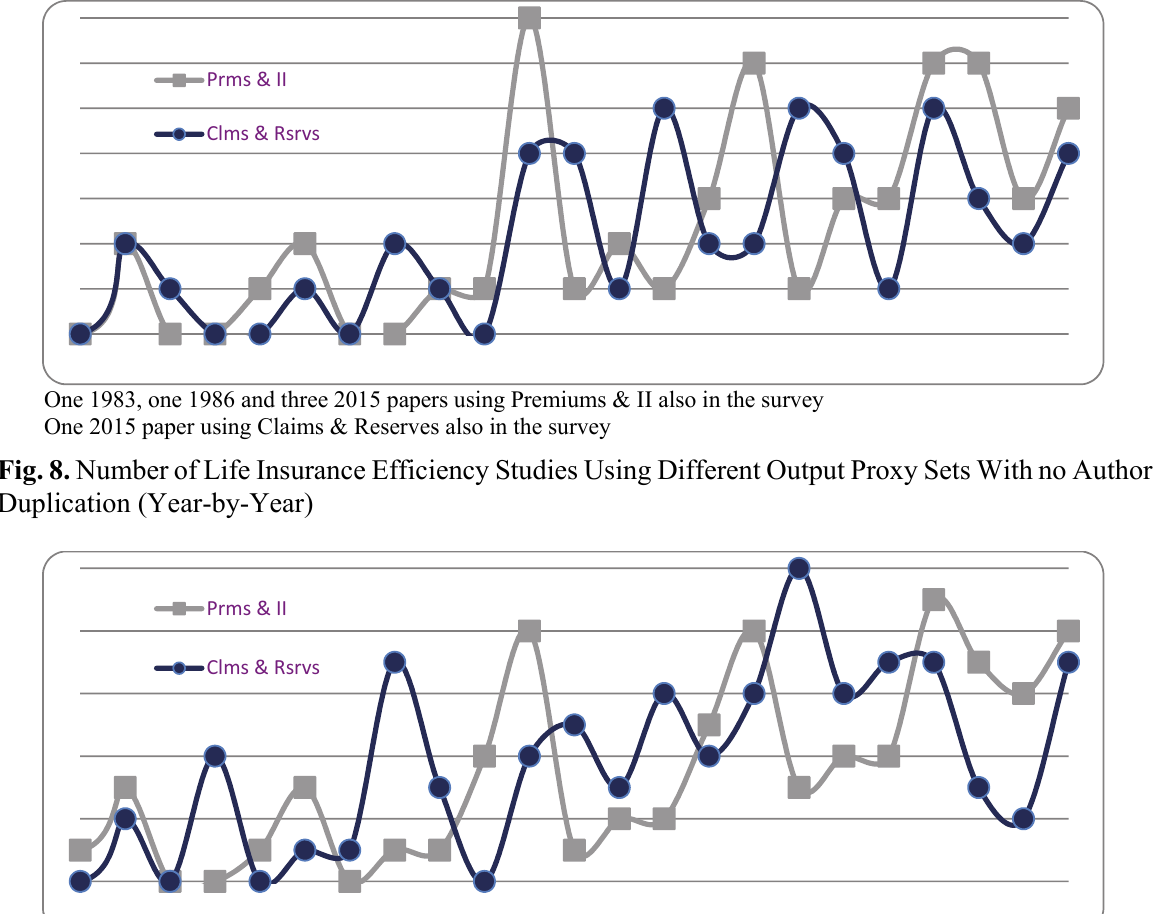
Fig. 9. Number of Life Insurance Efficiency Studies Using Different Output Proxy Sets (Year-by-Year)